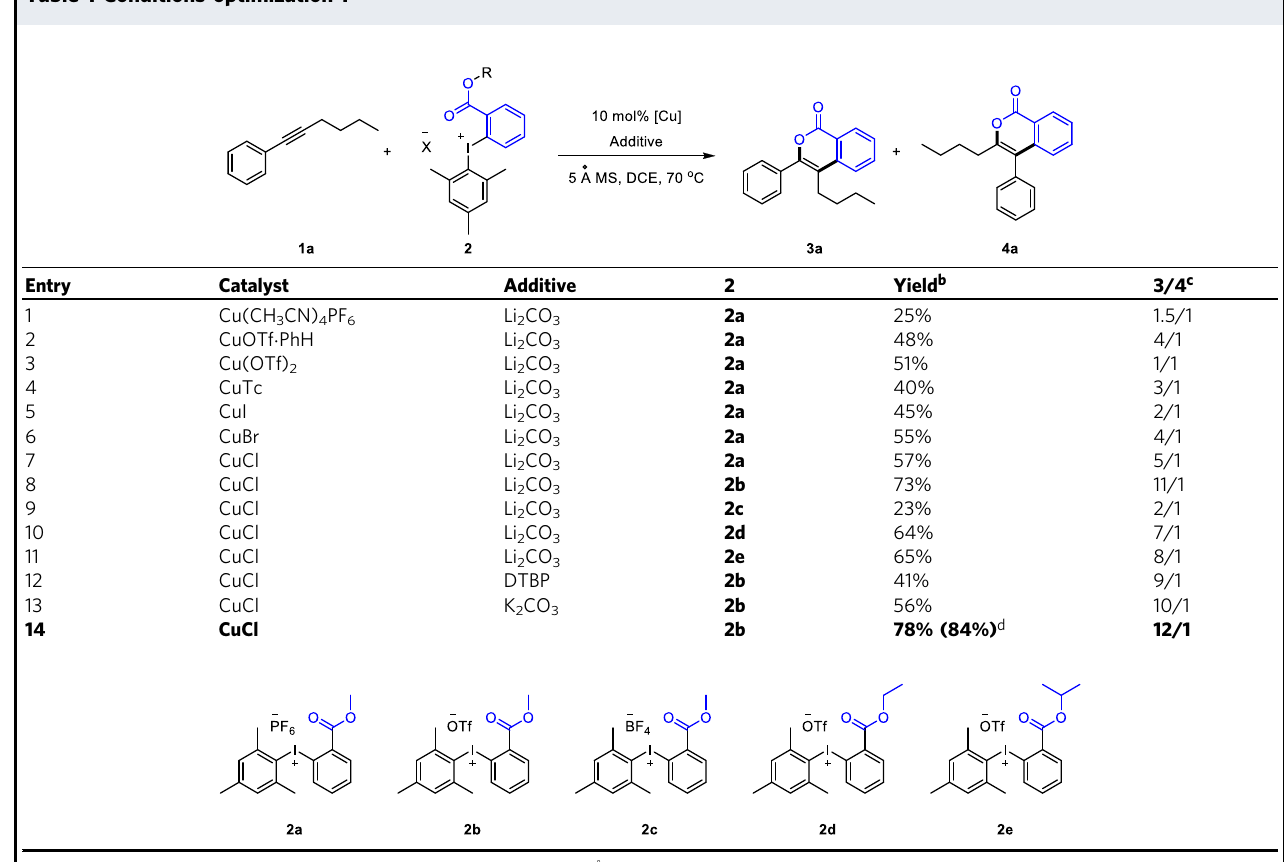
Table 1 Conditions optimization a